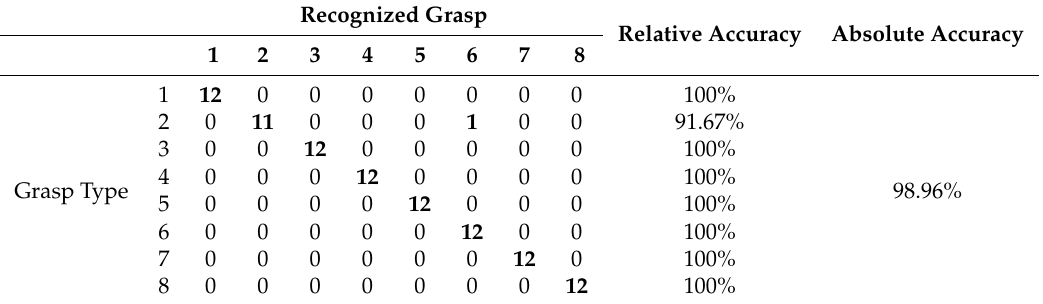
Table 5. Results: Volunteer